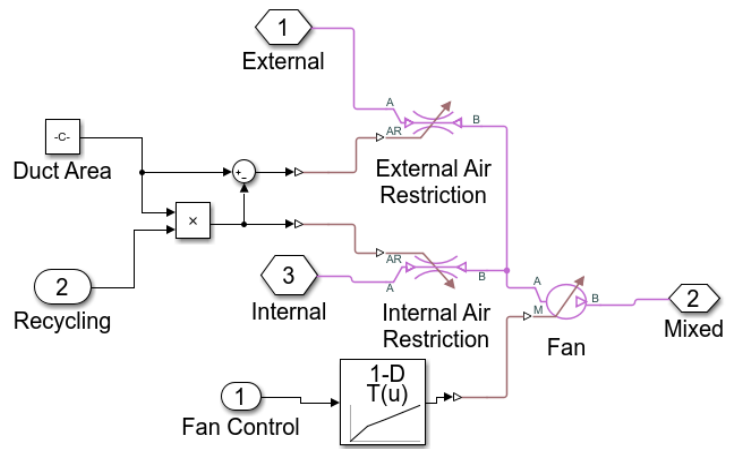
Figure 3. The fan control block [15].